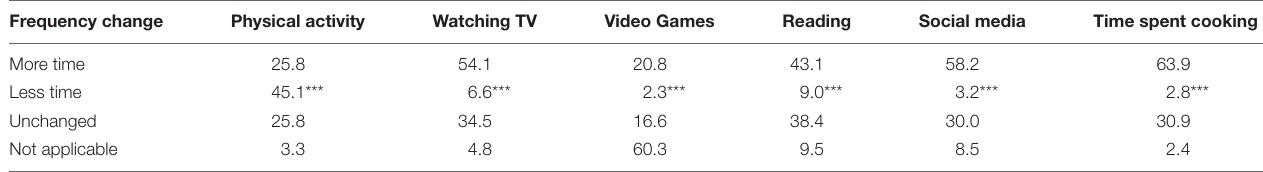
TABLE 3 | Percentage distribution and chi-square tests for increases (decreases) in the frequency of different types of activity. Frequency change Physical activity Watching TV Video Games Reading